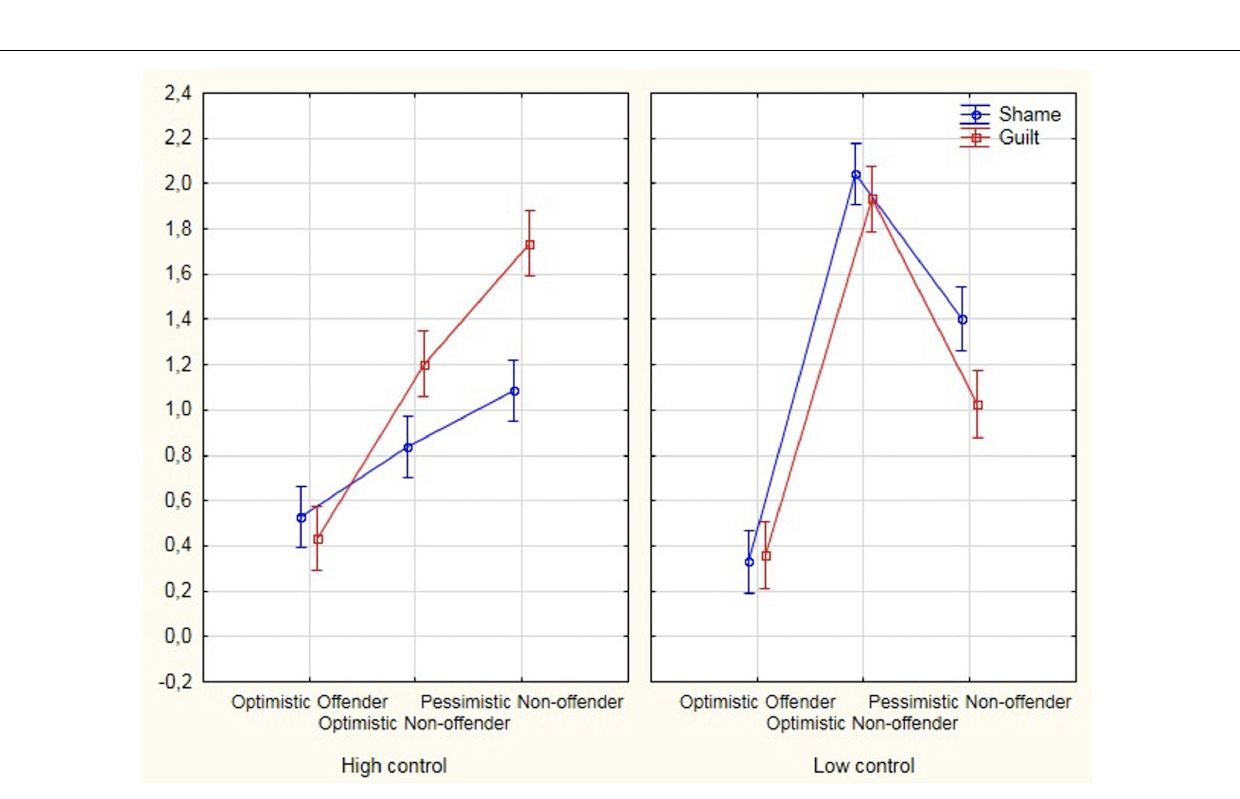
FIGURE 2 | Effect of interaction between (guilt and shame) negative emotion factor on study group and task